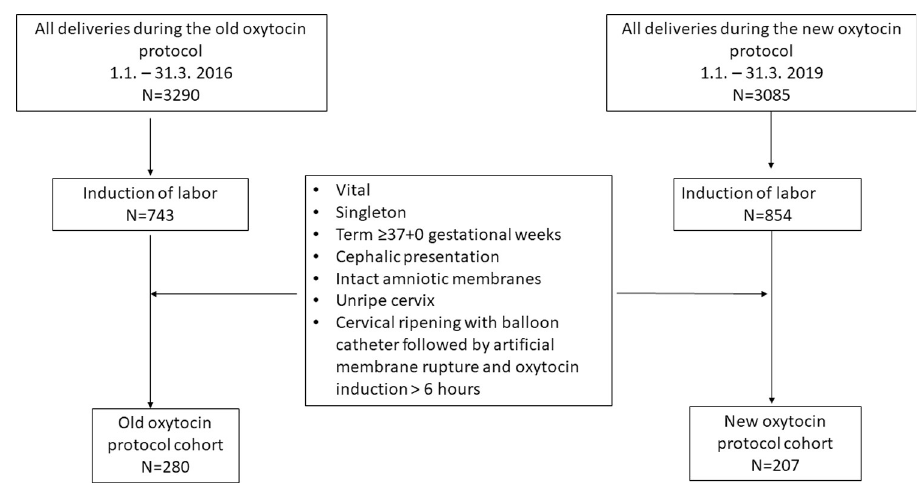
Fig 1. Flowchart of the study population.